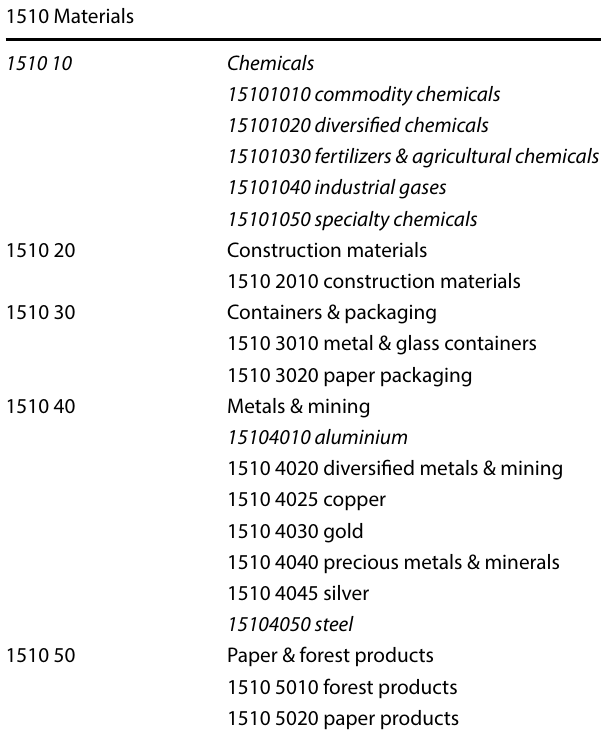
Table 1 Global Industry Classification Standard (GICS)—materials sector 1510